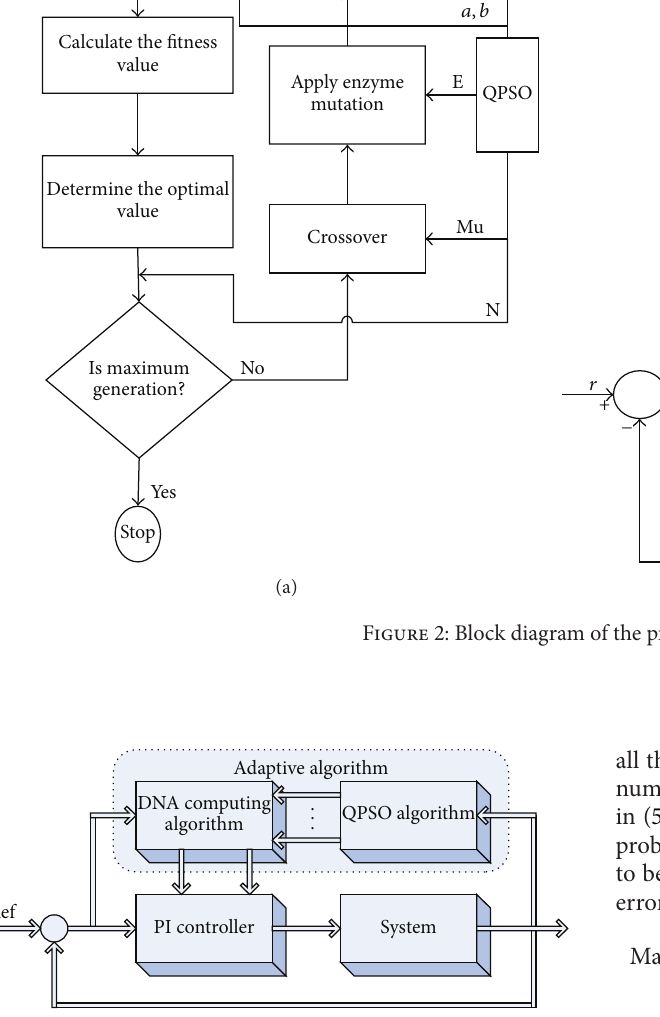
Figure 3: Schematic diagram of the